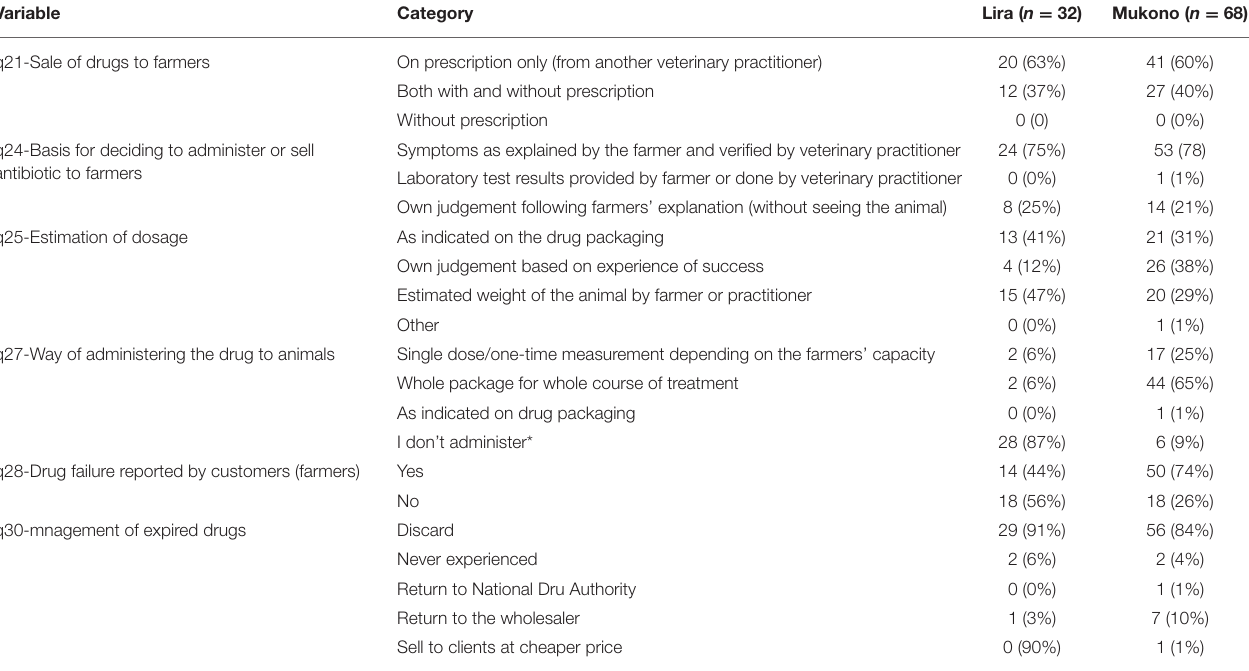
TABLE 6 | Practices of veterinary practitioners in drug use.